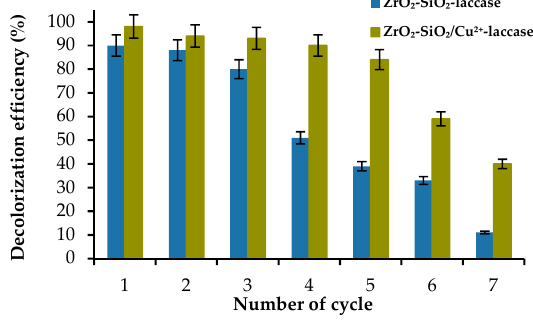
Figure 10. Reusability of the obtained biocatalytic systems.